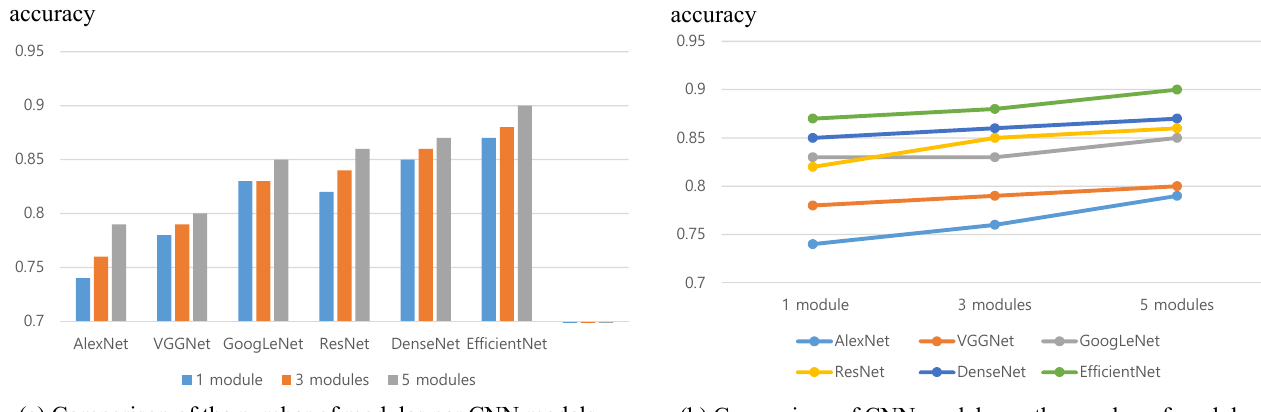
Figure 12. Result of our baseline experiment: Comparison of the CNN models and the number of